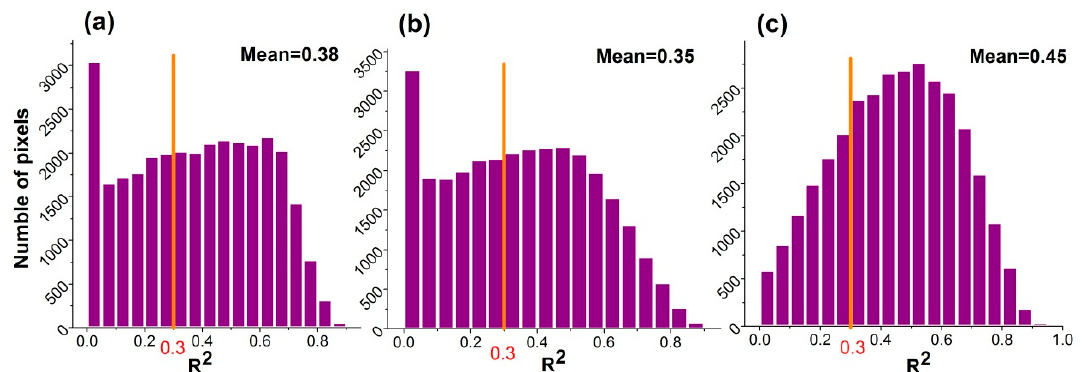
Figure 7. Statistics of R 2 between NDVI acc and precipitation of ( a ) RESTREND, ( b ) the second trial, and ( c ) P-RESTREND.